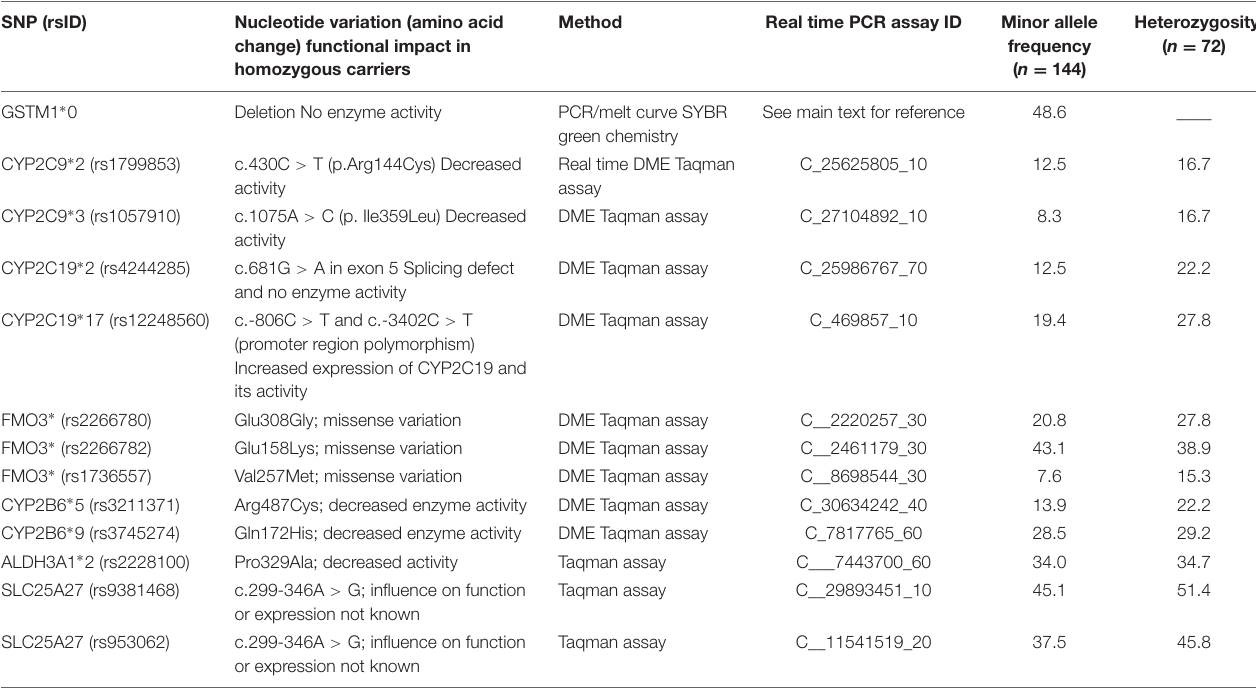
∗ Single-nucleotide polymorphisms (SNPs) in FMO3 gene were predicted to be tolerant using prediction tools such as sorting intolerant from tolerant (SIFT) and protein analysis through evolutionary relationships (PANTHER), except rs2266780 that was predicted to be damaging to gene function by SIFT.